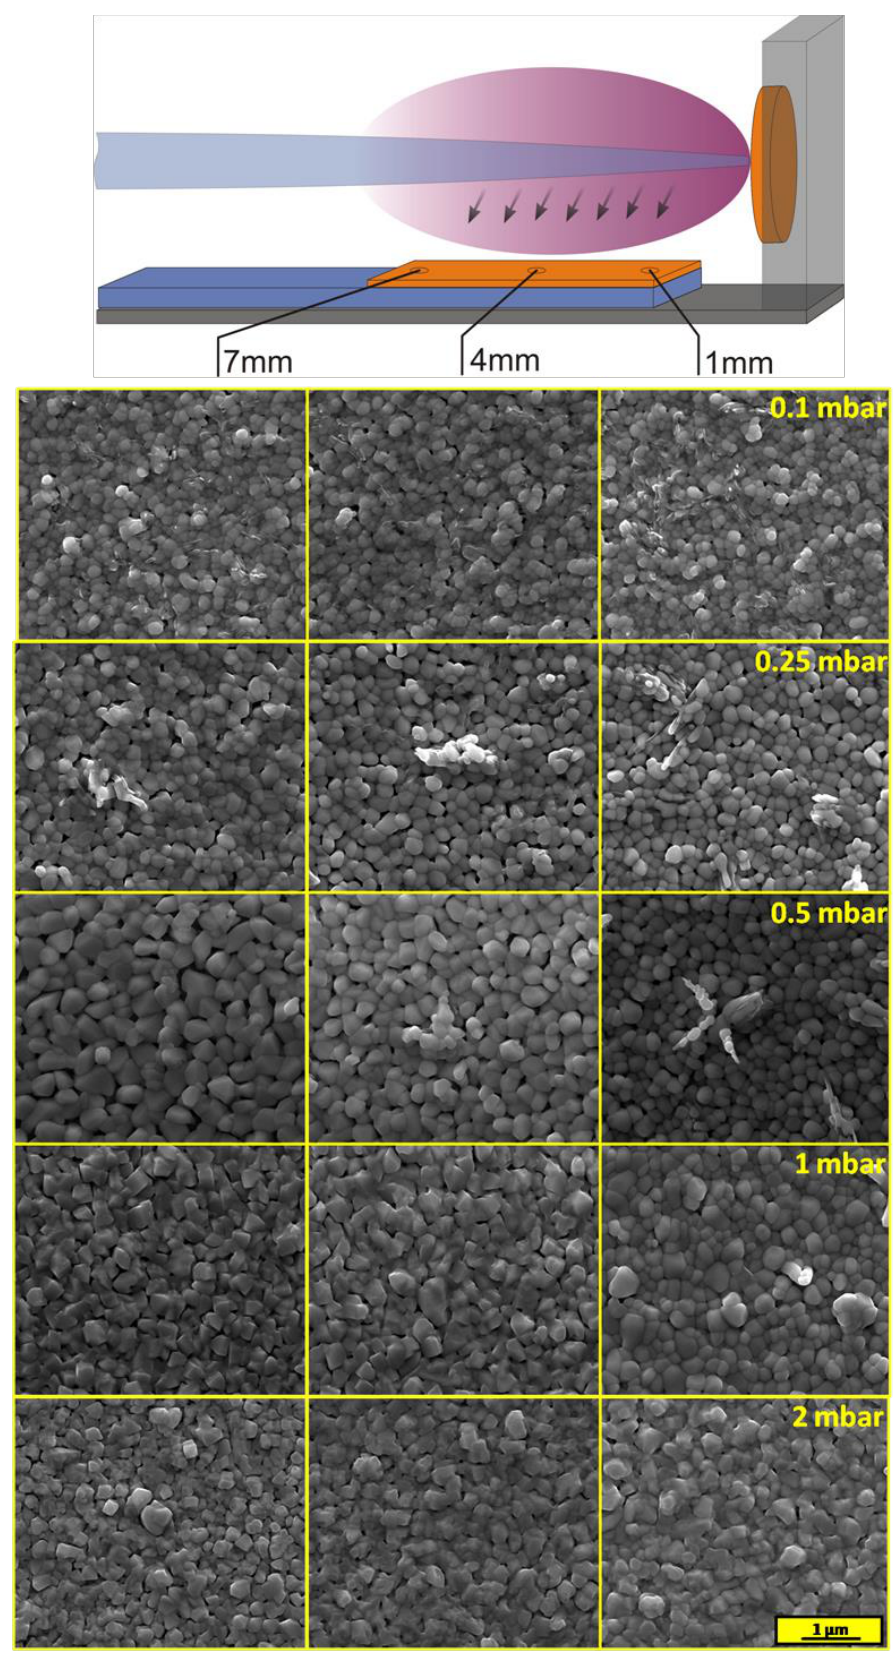
Figure 6. SEM images taken at different spots of the samples deposited under 0.1, 0.25, 0.5, 1, and 2 mbar.